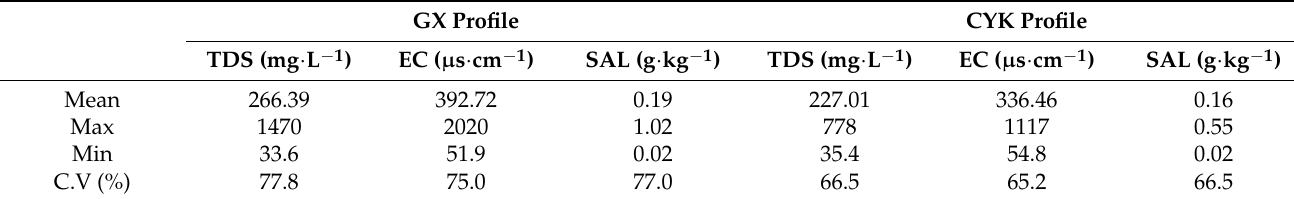
Figure 5. Variation characteristics of physicochemical property indexes of sediment lixivium in GX ( a ) and CYK ( b ) profiles. Table 1. Changes of physicochemical properties of sediment lixiviums of GX and CYK